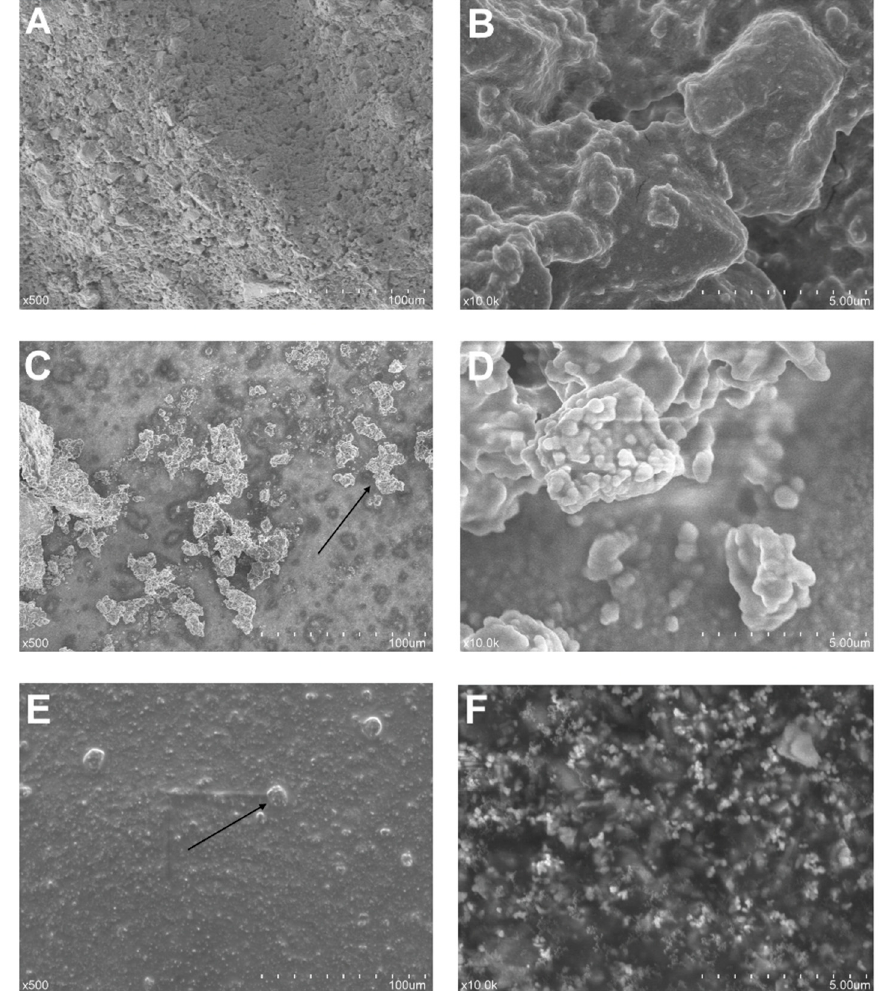
Figure 1. Sample morphology under scanning electron microscopy (SEM) after 1 week of setting at 37 ◦ C and 95% humidity: ( A ) ProRoot MTA sample, 500 × ; ( B ) ProRoot MTA sample, 10,000 × ; ( C ) Biodentine sample, 500 × ; ( D ) Biodentine sample, 10,000 × ; ( E ) Bio-C Repair sample, 500 × ; and ( F ) Bio-C Repair sample, 10,000 × . The arrows indicate exophytic areas.